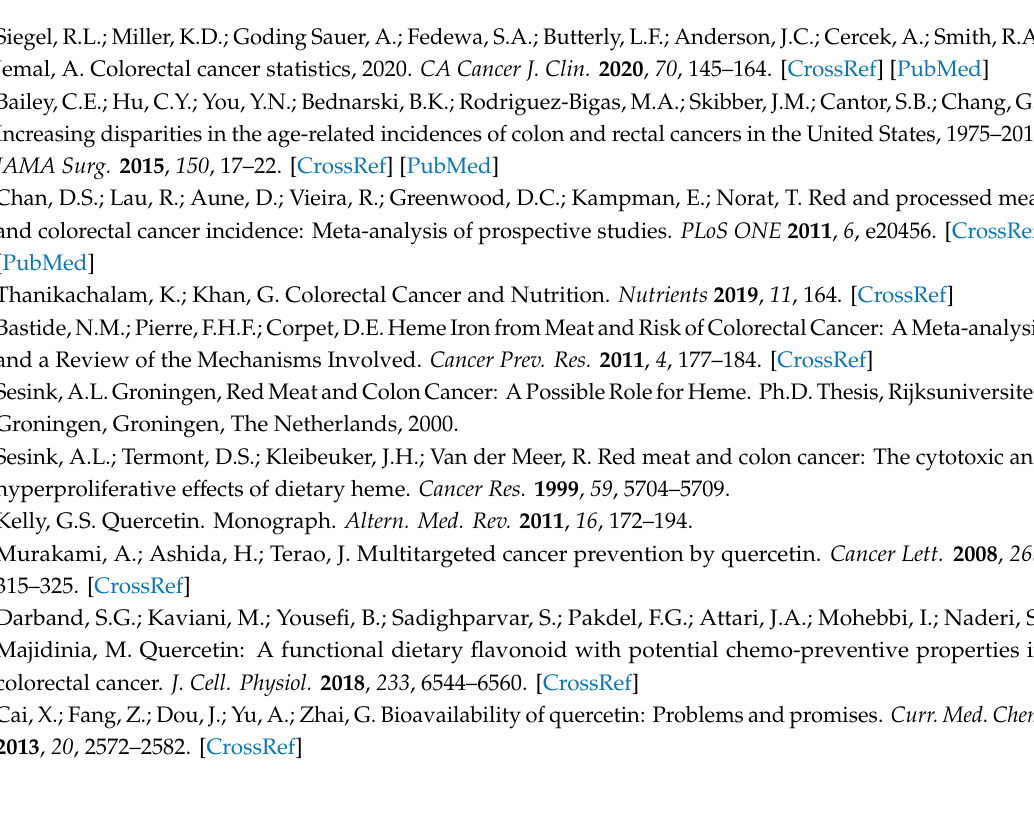
Figure S3: Comparison of the e ff ect of QUE and 3,4HPAA in ROS levels, Figure S4: Comparison of the e ff ect of QUE and 3,4HPAA in mitochondrial